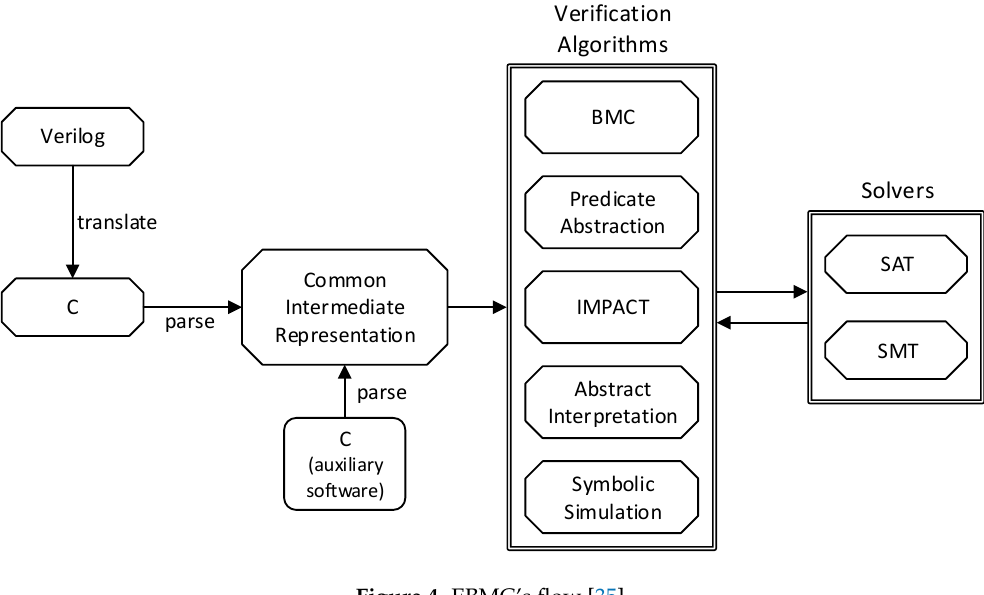
Figure 4. EBMC’s flow